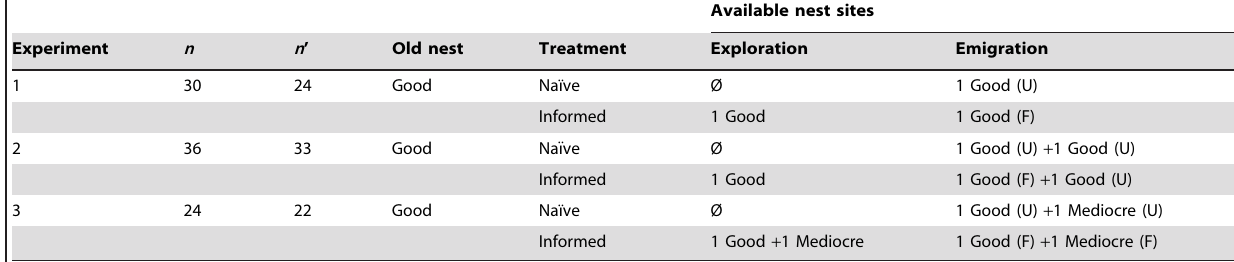
Table 1. Experimental